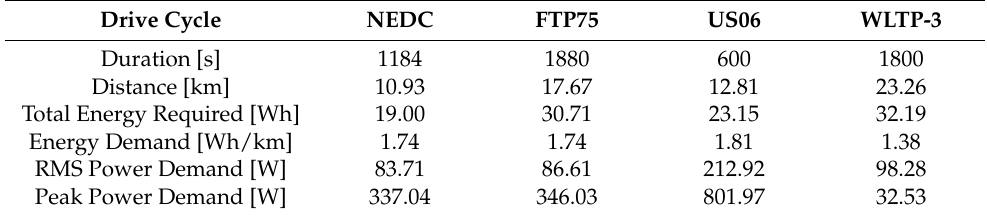
Table 3. Energy and Power Demands of Legislative Drive Cycles (Power-based